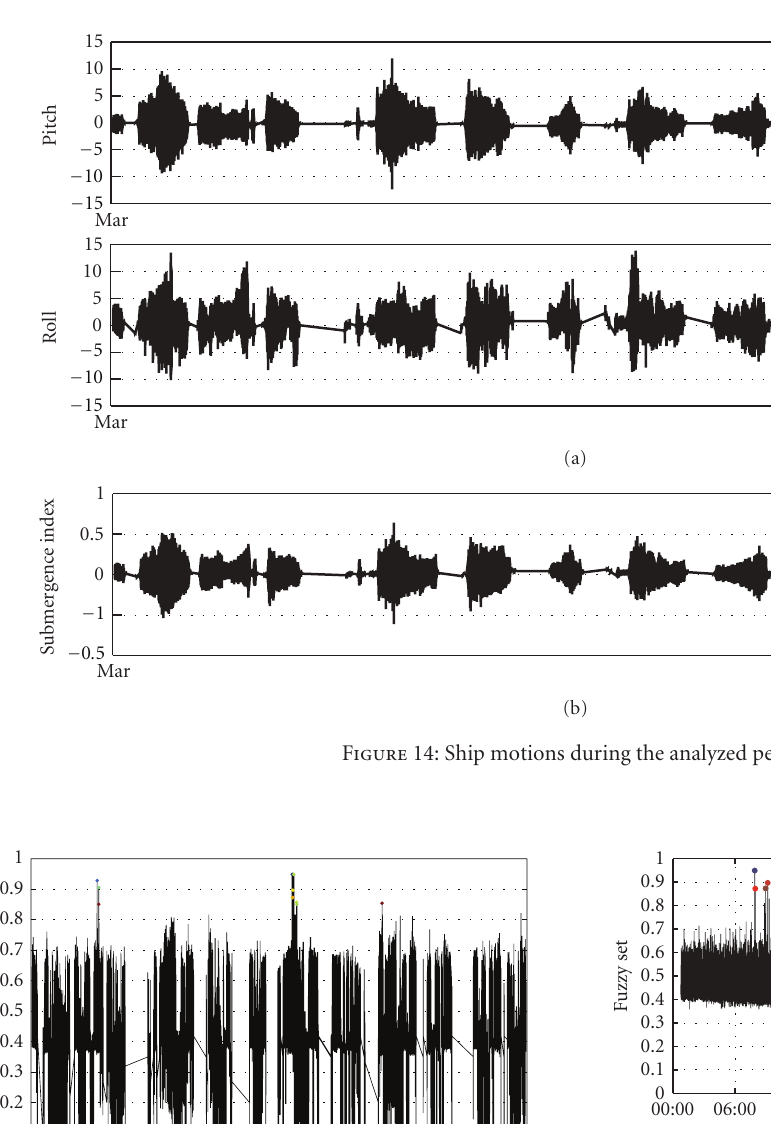
Figure 16: Time series of the membership